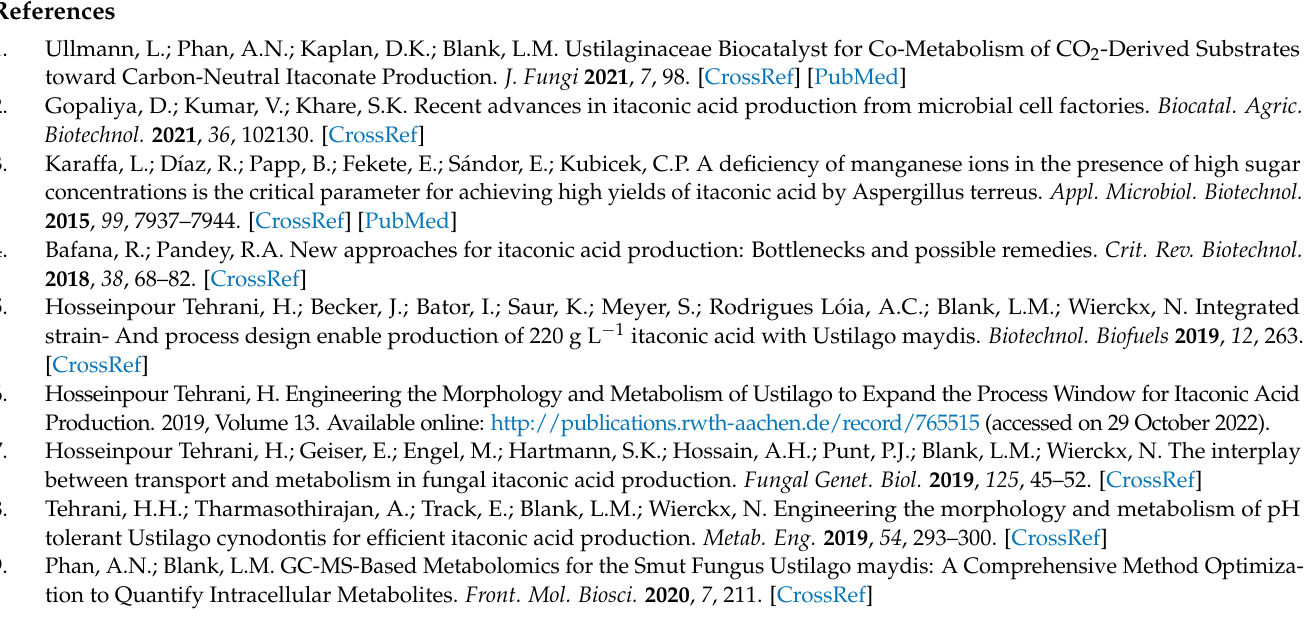
Figure S7: Interaction between glucose, formate, and ammonium chloride on itaconate yield obtained via DoE approach; Figure S8: Organic solvent tolerance test in U. cynodontis #2705; Figure S9: Pressure-drop curve of the CO 2 hydrogenation in presence of NaOH and cis-[RuCl 2 (C1 2 -dppm) 2 ] in apolar solvent/H 2 O with A: tetradecane, B: octylacetate, and C: anisole as catalyst phase; Table S1: Welch t -test result for shake flask cultivations of metabolically engineered U. cynodontis strains; Table S2: Tested DoE conditions and responses during this study; Table S3: Results from the CO